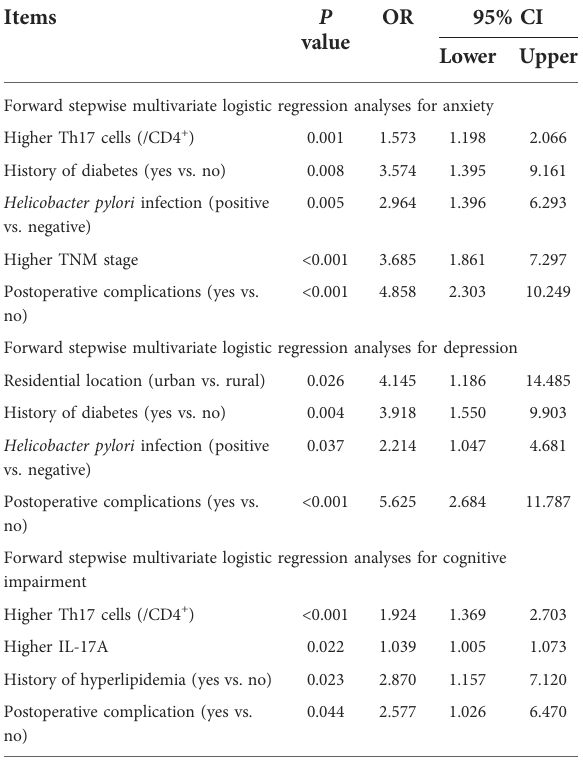
TABLE 6 Forward stepwise multivariate logistic regression analyses for anxiety, depression, and cognitive impairment.